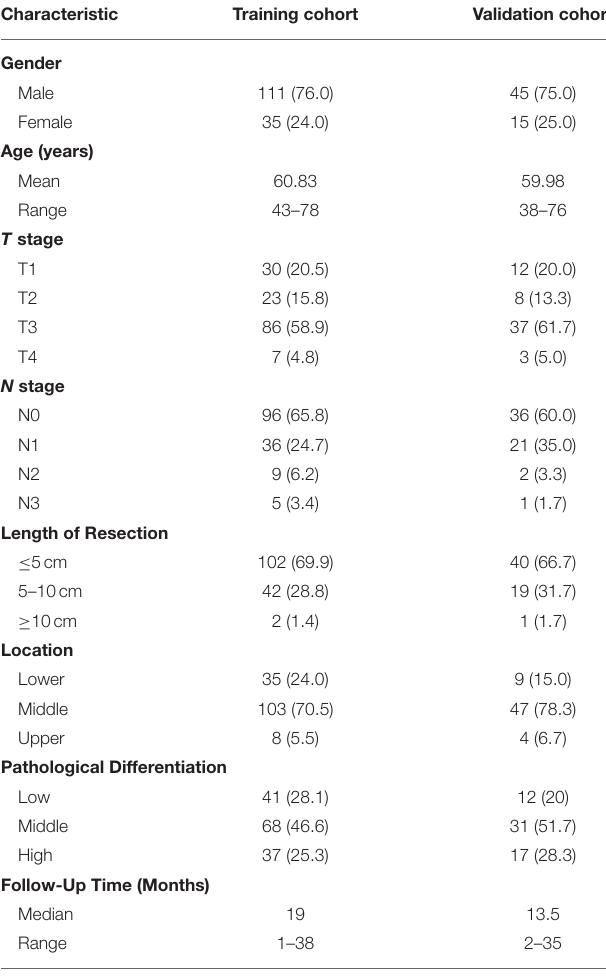
TABLE 1 | Demographic and clinical characteristics of patients with ESCC in the training cohort and validation cohort.